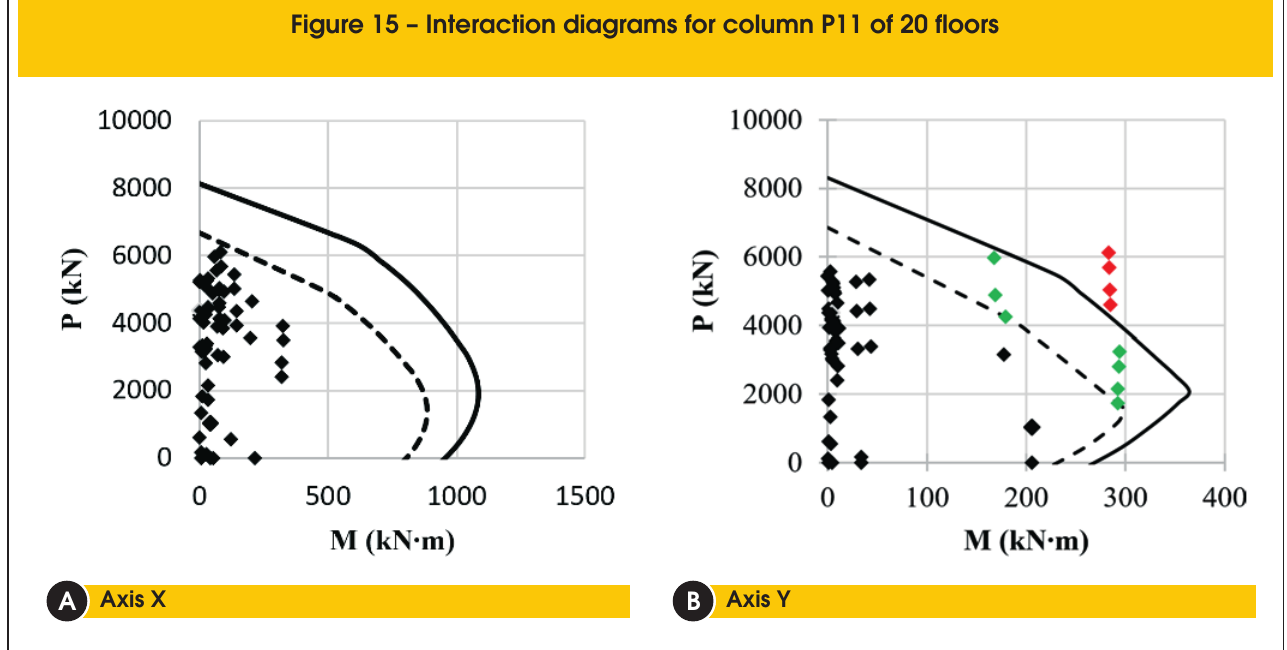
Figure 15 – Interaction diagrams for column P11 of 20